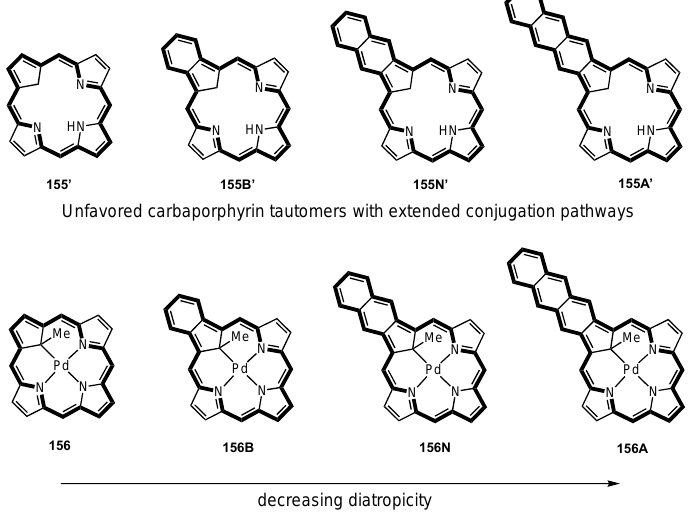
Figure 6. Carbaporphyrin tautomers and extended aromatic conjugation pathways in palladium(II)